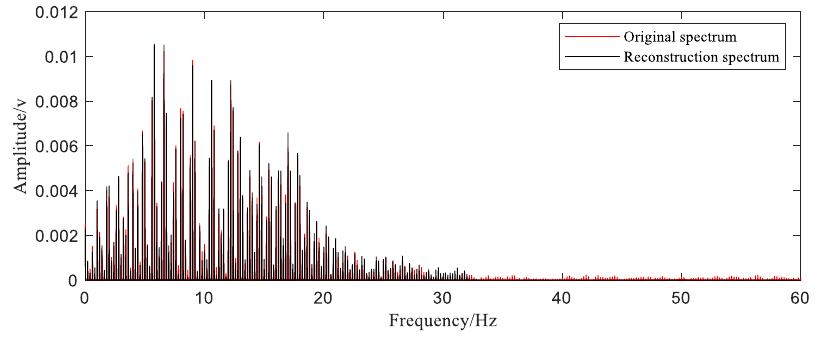
Figure 14. Spectrum comparison. Figure 14. Spectrum